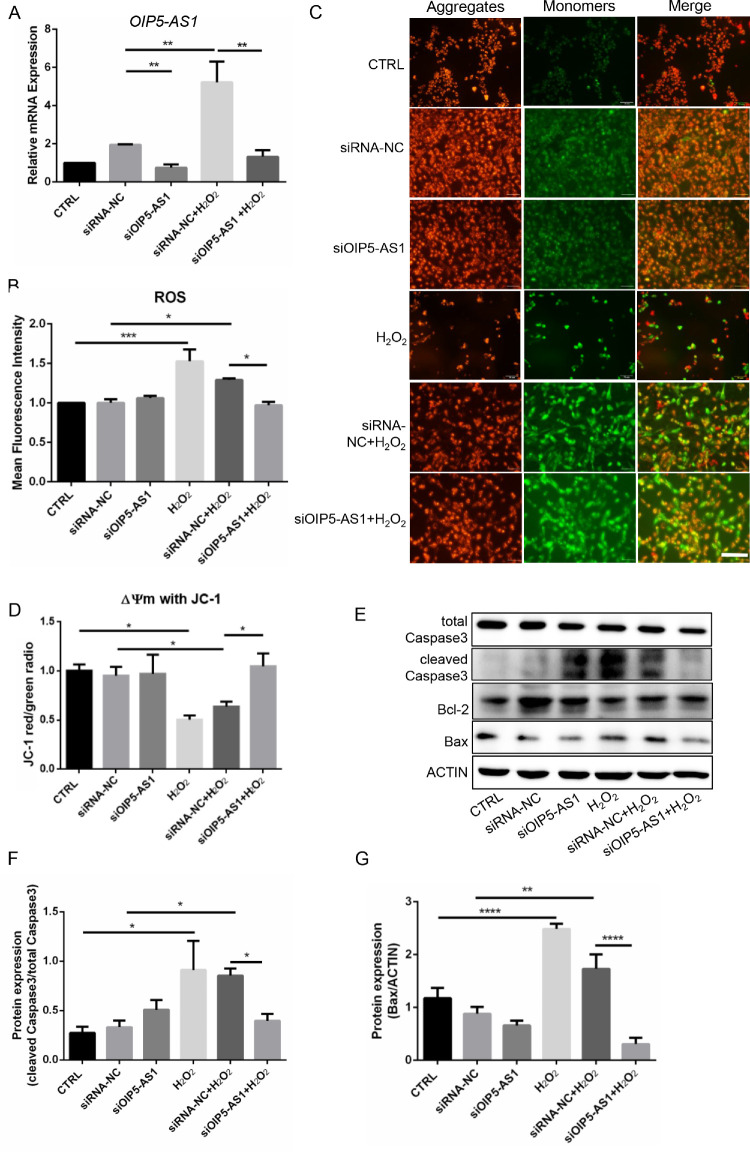

OIP5-AS1 knockdown alleviated cell apoptosis and ROS production. (A) mRNA level of OIP5-AS1 quantified by RT-qPCR. SiRNA silencing abolished H2O2-enhanced OIP5-AS1 expression. (B) Flow cytometric detection of the mean fluorescence intensity of the cell ROS. (C–D) Analysis of MMP staining by JC-1with a fluorescence microscope and microplate spectrophotometer. The JC-1 monomer was green, indicating a low MMP, and JC aggregates were red, indicating a high MMP. Scale bar: 500 µm. (E) Western blot of apoptosis-associated proteins. (F–G) Quantification of the Western blot results. *P < 0.05, **P < 0.01, ***P < 0.0001, ****P < 0.00001.